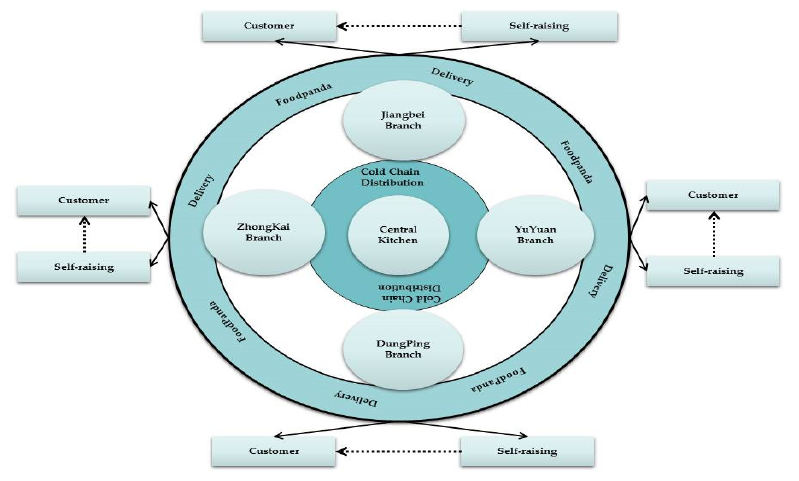
Figure 2. Cake supply chain summary.